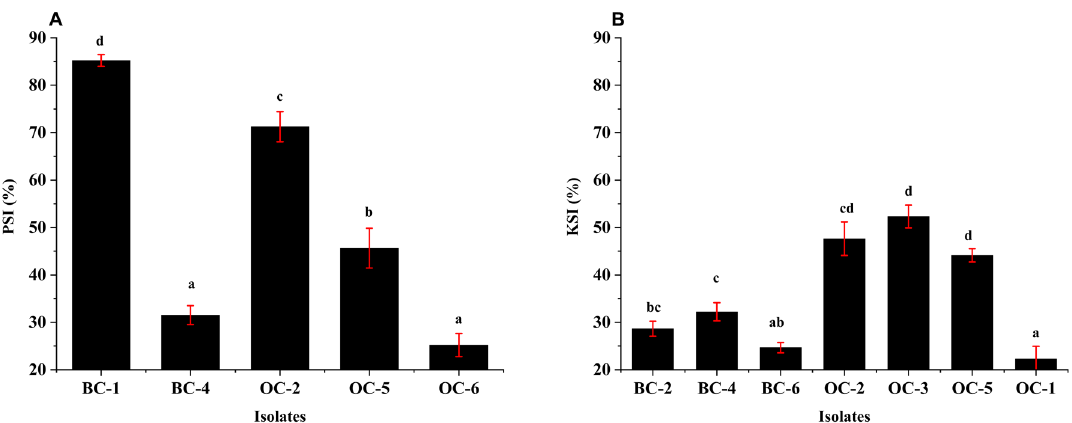
Figure 1. Quantitative estimation of ( A ) Phosphate Solubilizing index and ( B ) Potassium Solubilizing index of the potential Isolates. Results are expressed as means of three replicates and vertical bars shown in the figure represent standard deviations and different letters indicate significant differences at p < 0.05 by T’s-Test.